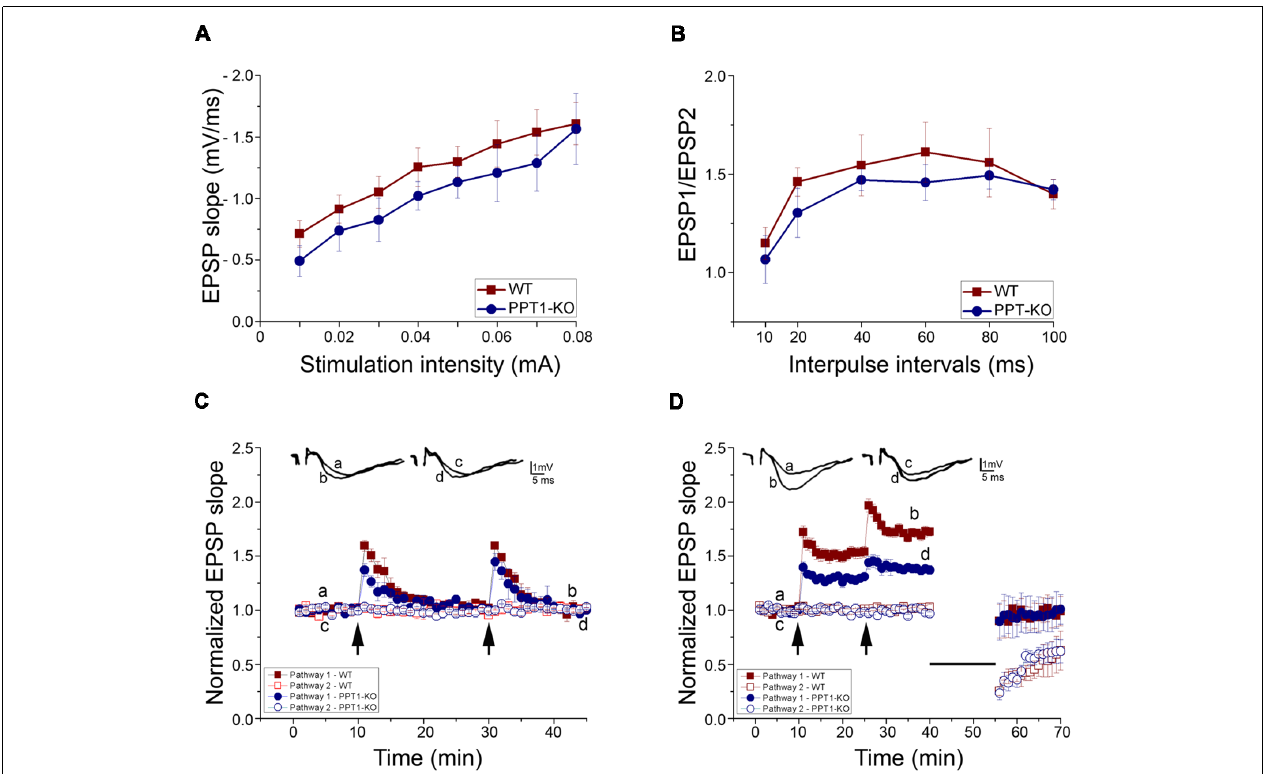
FIGURE 5 | Electrophysiology of transverse hippocampal slices from control and Ppt1 KO animals. (A) Input-output curves of field excitatory postsynaptic potential (fEPSP) slopes for WT and Ppt1 KO mouse hippocampal slices showing no significant difference between groups. (B) Paired-pulse facilitation (PPF) of the fEPSP slopes expressed as response to the 2nd stimulation over the 1st at different interpulse intervals (IPIs; 10, 20, 40, 60, 80, and 100 ms) in WT and PPT1-KO slices. No significant difference in PPF was found. (C) Short tetanic stimulation, subthreshold to long-term potentiation (LTP) induction (35 pulses, 100 Hz), was delivered twice to one pathway. The arrows denote the points at which the tetanic stimulation was delivered. The stimulation produced a transient, short term potentiation (STP) which was larger in WT than Ppt1 KO slices (1.59 ± 0.05 and 1.37 ± 0.06 ( n = 4 in both groups, P < 0.05), correspondingly). (D) LTP was induced by high-frequency stimulation, (HFS, 100 Hz, 1 s) at twice the test intensity. The arrows denote the points at which tetanic stimulation was delivered twice to one pathway. The second train produced a further increase in the response. Ppt1 KO slices expressed a significantly lower magnitude LTP than WT [1.38 ± 0.004 ( n = 7; P < 0.001, F value 201.16) compared with 1.71 ± 0.01 ( n = 7) in